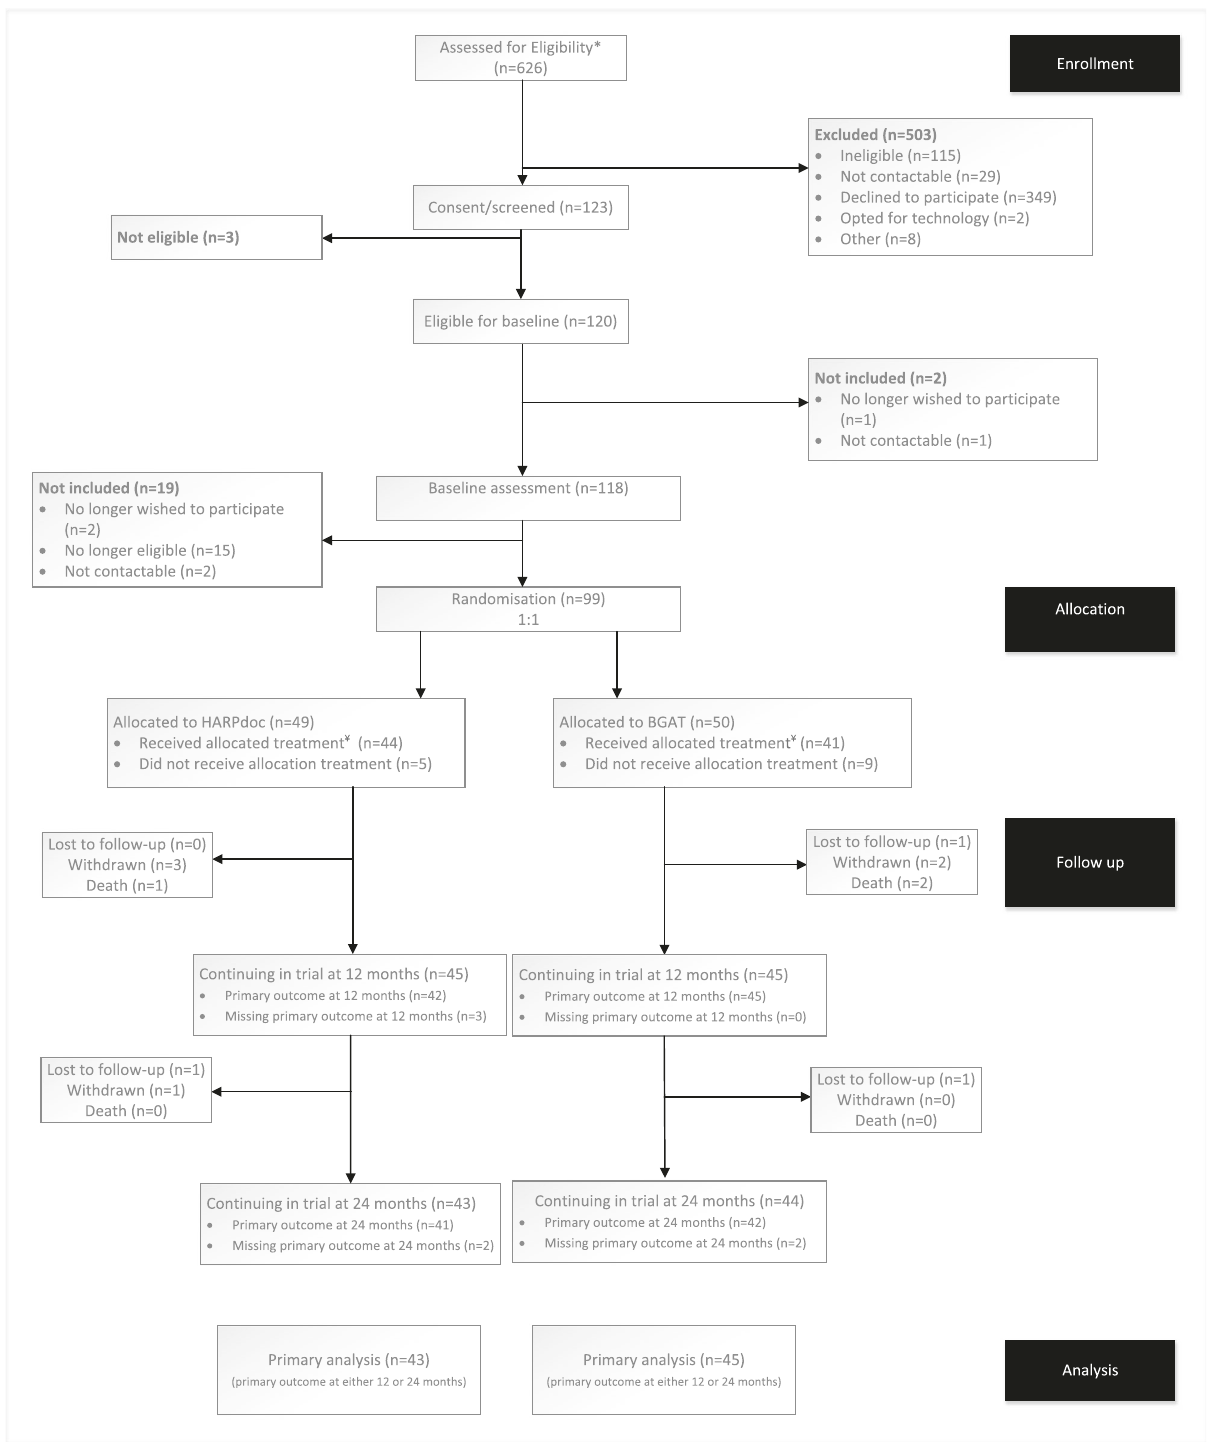
Fig. 1 CONSORT diagram for the HARPdoc RCT, showing participant fl ow through the study. Participant numbers at each stage are shown in the fi gure. * Patients judged as potential participants for the trial, including some ( n = 329) identi fi ed through remote review of electronic patient records by researchers followed by “ cold call ” and others identi fi ed at clinical team meetings. ¥ Attendance of at least the fi rst 3 days of allocated treatment (HARPdoc or BGAT) plus at least one 1:1 session for HARPdoc was considered as “ received allocated treatment ” . admissions ( N = 91). Gold and Clarke scores 30,31 were high diabetes distress, using the Problem Areas in Diabetes ques- (mean ± SD 5.5 ± 1.2; 5.4 ± 1.1 respectively, shown by group in tionnaire (PAID), was not above the cut point for being high 32 Table 4, data columns 1 and 2), con fi rming IAH. Over half the but had a wide range (31.9 ± 20.1). Scores in the Hospital Anxiety cohort ( n = 54, 54.5%) had been experiencing problematic and Depression Score (HADS) 33 were high 34 (7.5 ± 4.6 and 5.9 ± 4.3, respectively), with 49.5 and 35.1% scoring 8 or more on hypoglycaemia for over ten years (Table 1). Mean(±SD) score for NATURE COMMUNICATIONS| (2022) 13:2229 |https://doi.org/10.1038/s41467-022-29488-x|www.nature.com/naturecommunications